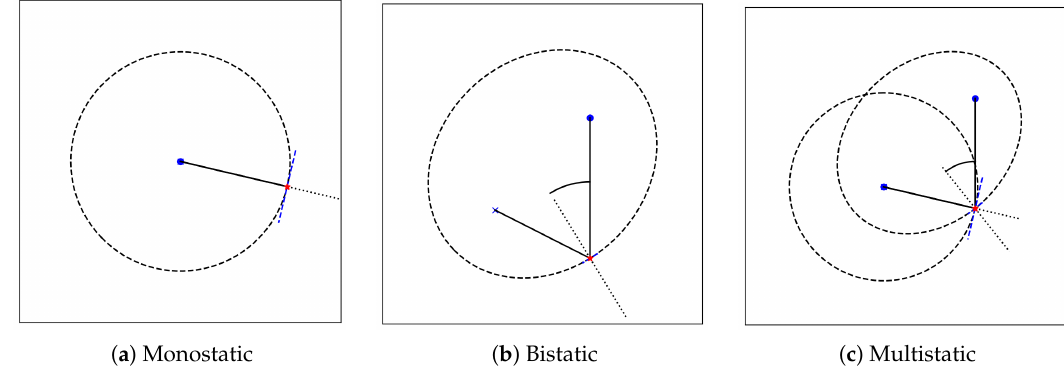
Figure 3. Comparison of ( a ) monostatic (receiver and transmitter colocated), ( b ) bistatic (receiver and transmitter separated) and ( c ) multistatic ( b with extra receiver) radar geometries. In each case, the transmitter is shown by the blue cross and the receiver is shown by the blue circle (in the monostatic case, is also at the same location as the transmitter). An example scatter point is shown by the red star and the path the signal takes is shown by the solid black line. The line of constant range for each particular range is shown by the dashed black line and the angle marker shown represents the bistatic